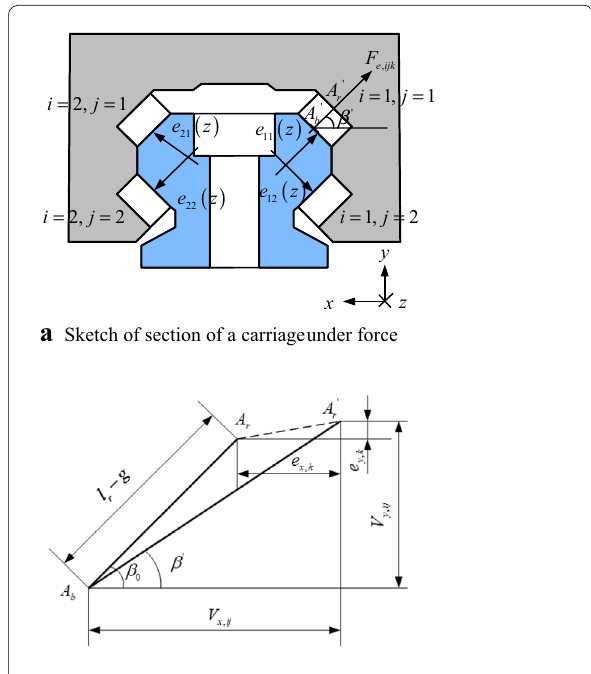
Figure 2 Model of single-carriage elastic